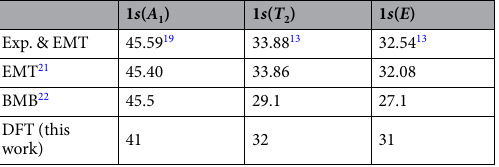
Table 1. Binding energies for the s manifold states of a phosphorus donor electron calculated using experiment, EMT, and DFT. The binding energies of DFT were calculated from wavefunctions computed with a supercell containing 10,648 atoms.